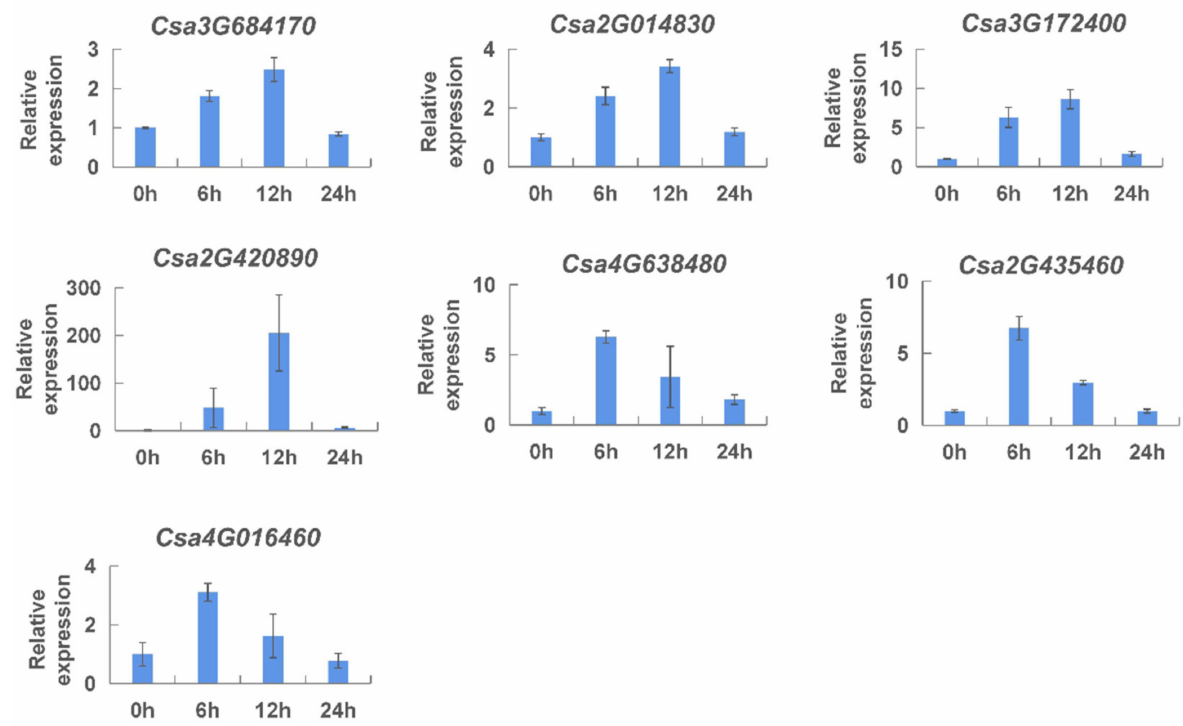
Figure 10. Expression analysis of the CNL genes responding to salicylic acid treatment in cucumber plants. The vertical axis is relative expression level and 0, 6, 12, 24 h on the x -axis indicate the treatment time. The expression level of transcript at 0 h was set to a value of ‘1’. Values are mean ± SE (n =